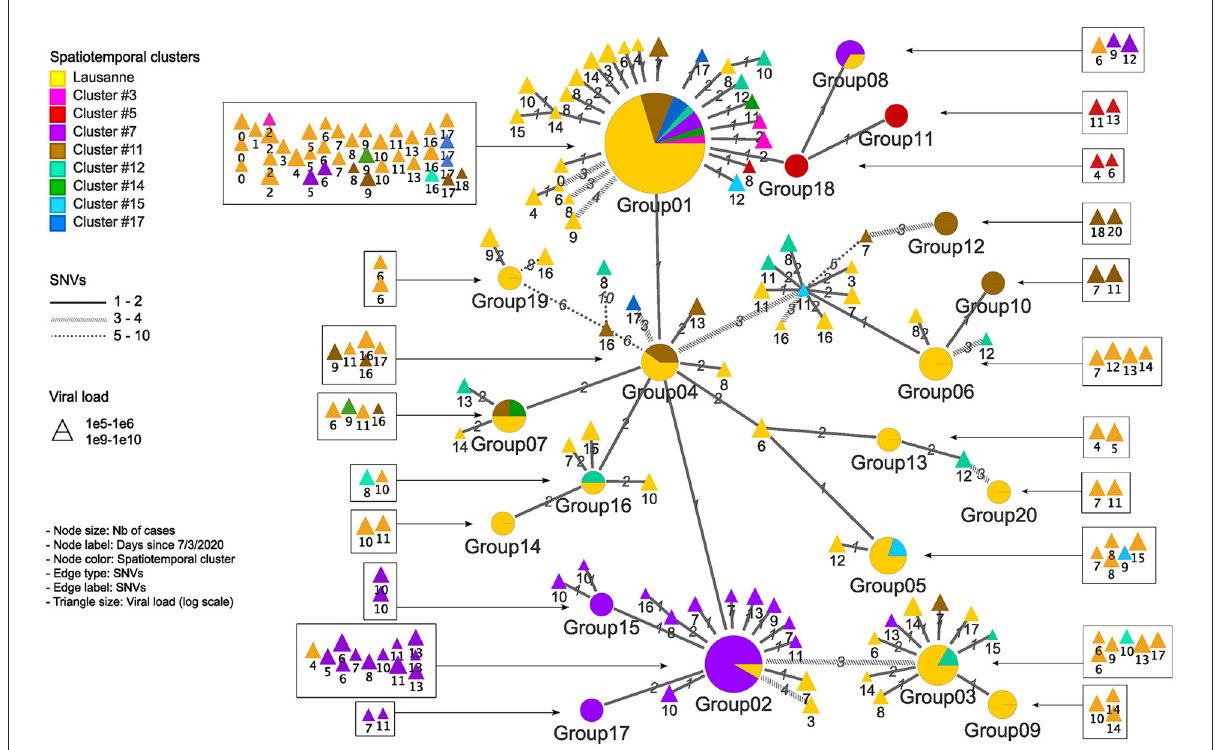
FIGURE4 Genetic relationship among genomic groups and singletons in minimum spanning tree. Nodes and edges indicate unique sequences and SNV distance. The number of cases in genomic groups is represented by the size of the pie. Genomic groups consist of cases in different geographical regions. The triangles are single cases with their size proportional to the log value of viral load detected by qPCR. They are represented in squares according to their occurrence in